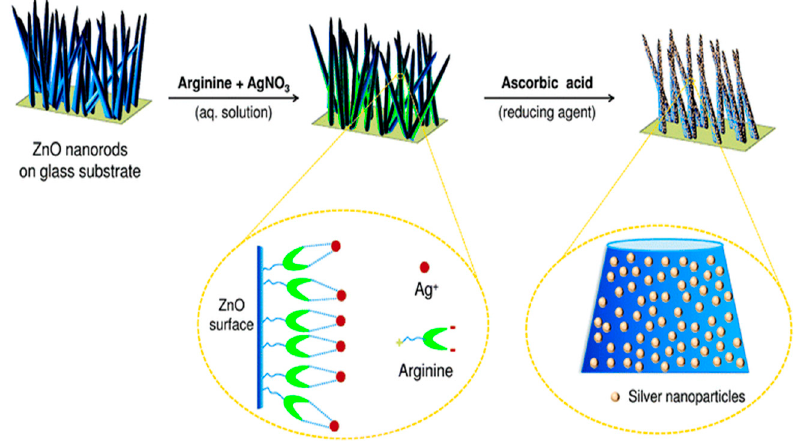
Figure 19. Schematic representation of the synthesis of AgNPs/ZnO nanocomposite using arginine as a linker to immobilize AgNPs on ZnO nanorods. Reproduced from [235] under a Creative Commons Attribution 3.0 Unported License.